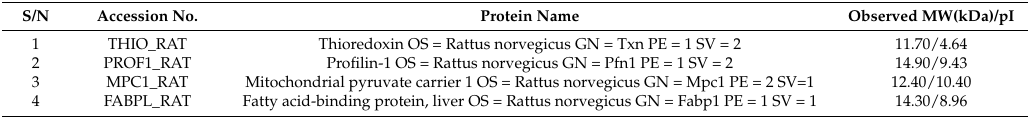
Figure 1. 1D SDS-PAGE gel from the liver of the experimental animals. Proteins (20 μ g) were separated by 1D SDS-PAGE and visualized by CBB staining. The protein profiles of four representative samples are shown in this figure. Lane 1: Molecular marker; lane 2: STZ PI 200; lane 4: STZ; lane 6: Control and lane 8: STZ PI 400. Table 1. Summary of all differentially expressed proteins identified form rat liver by nLC-MS.